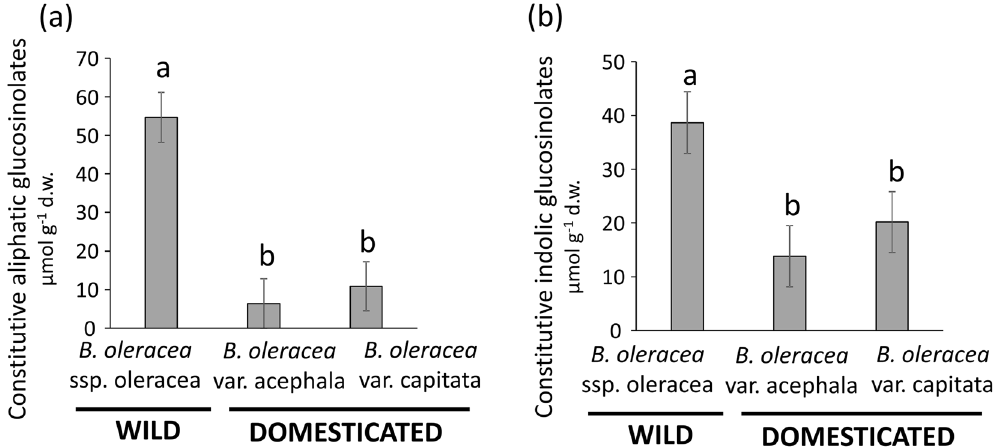
Figure 1. Effects of plant domestication on constitutive leaf chemical defences. Constitutive concentrations of (a) aliphatic glucosinolates and (b) indolic glucosinolates in leaves of wild cabbage ( Brassica oleracea ssp. oleracea) and two domesticated varieties of this species ( B . oleracea var. acephala and B . oleracea var. capitata). Bars are least square means ± s.e.m. (N = 60 plants per plant line). Different letters indicate significant ( P < 0.05) differences between plant lines (see Table 1 for statistics). d.w. = dry